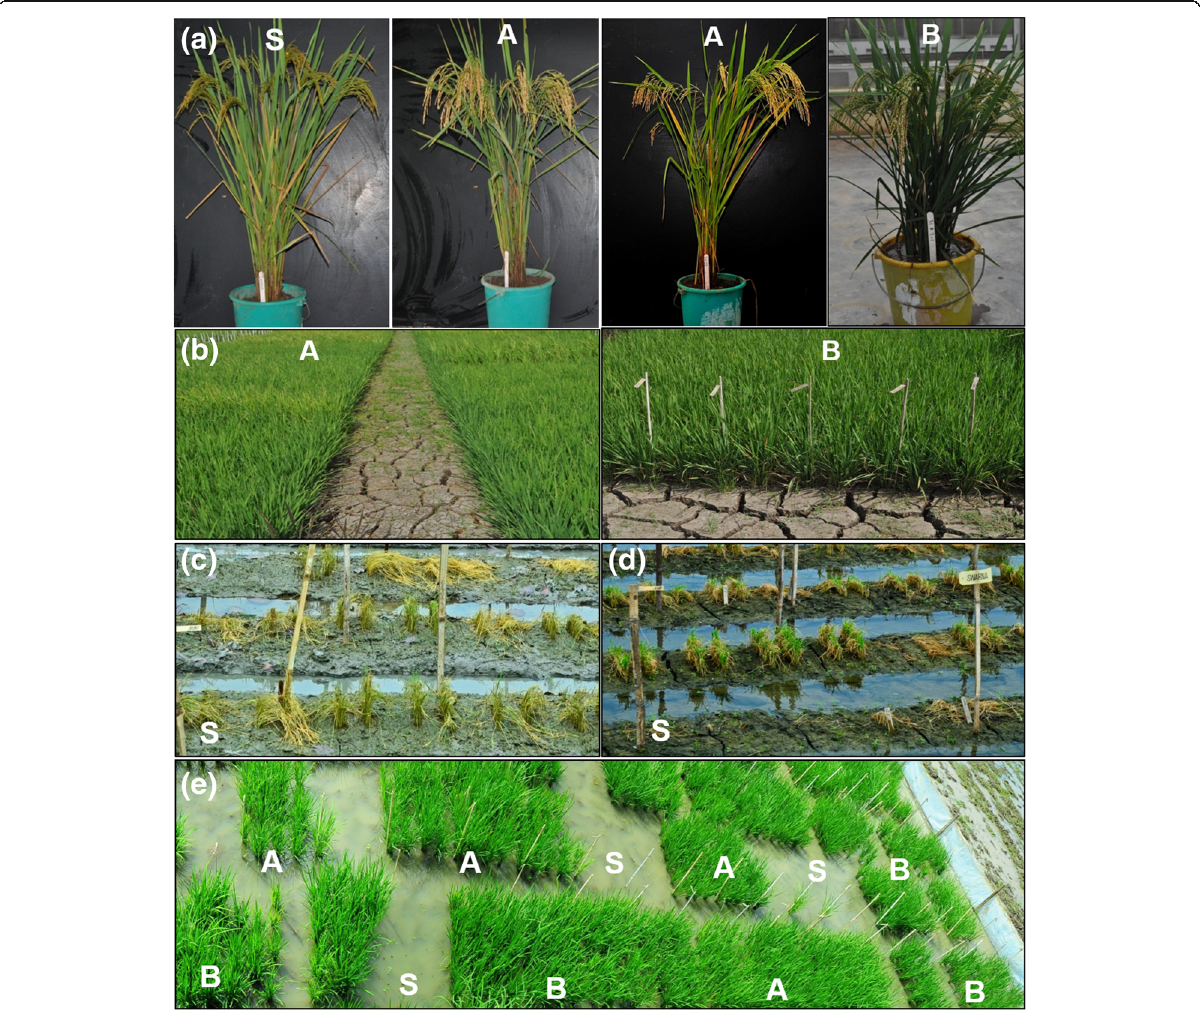
Fig. 1 a The morphological differences between Swarna and introgressed NILs; b field view of introgressed NILs under reproductive stage drought stress condition; submergence tolerance of introgressed NILs compared to Swarna ( c ) one day after draining; d six day after draining; e recovery of introgressed NILs compared to Swarna one month after draining. S: Swarna, A: introgressed NIL with qDTY 2.1 + qDTY 3.1 + Sub1 B: introgressed NIL with qDTY 1.1 + qDTY 2.1 + qDTY 3.1 +